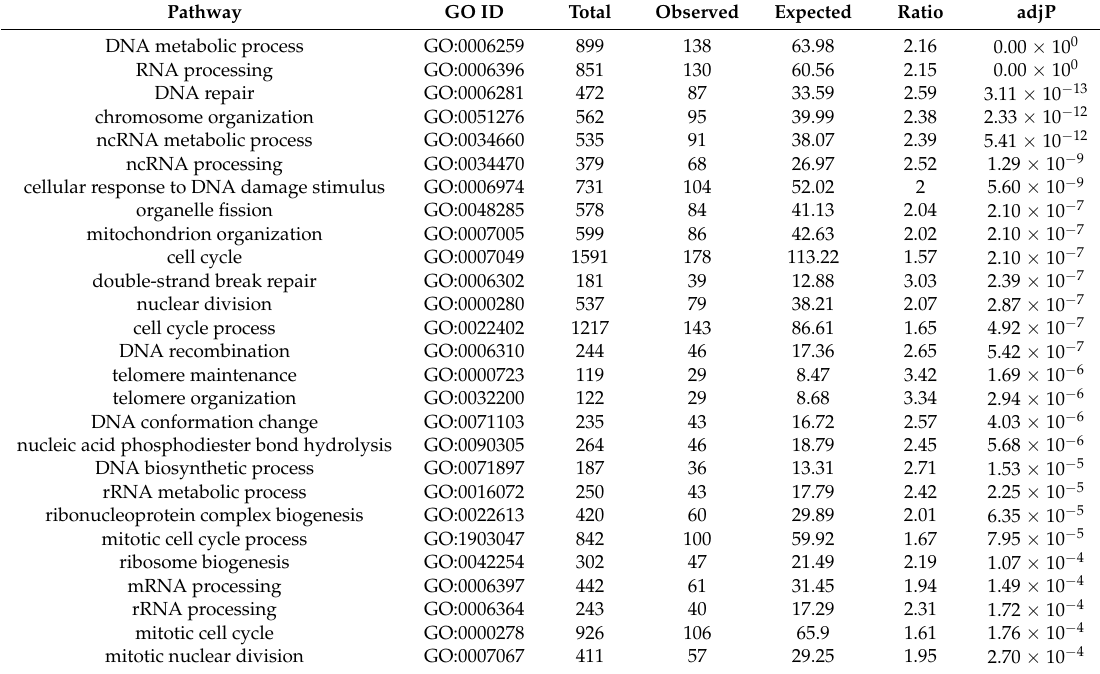
Table 4. Enrichment of genes with C/C bidirectional promoters for gene ontology biological process